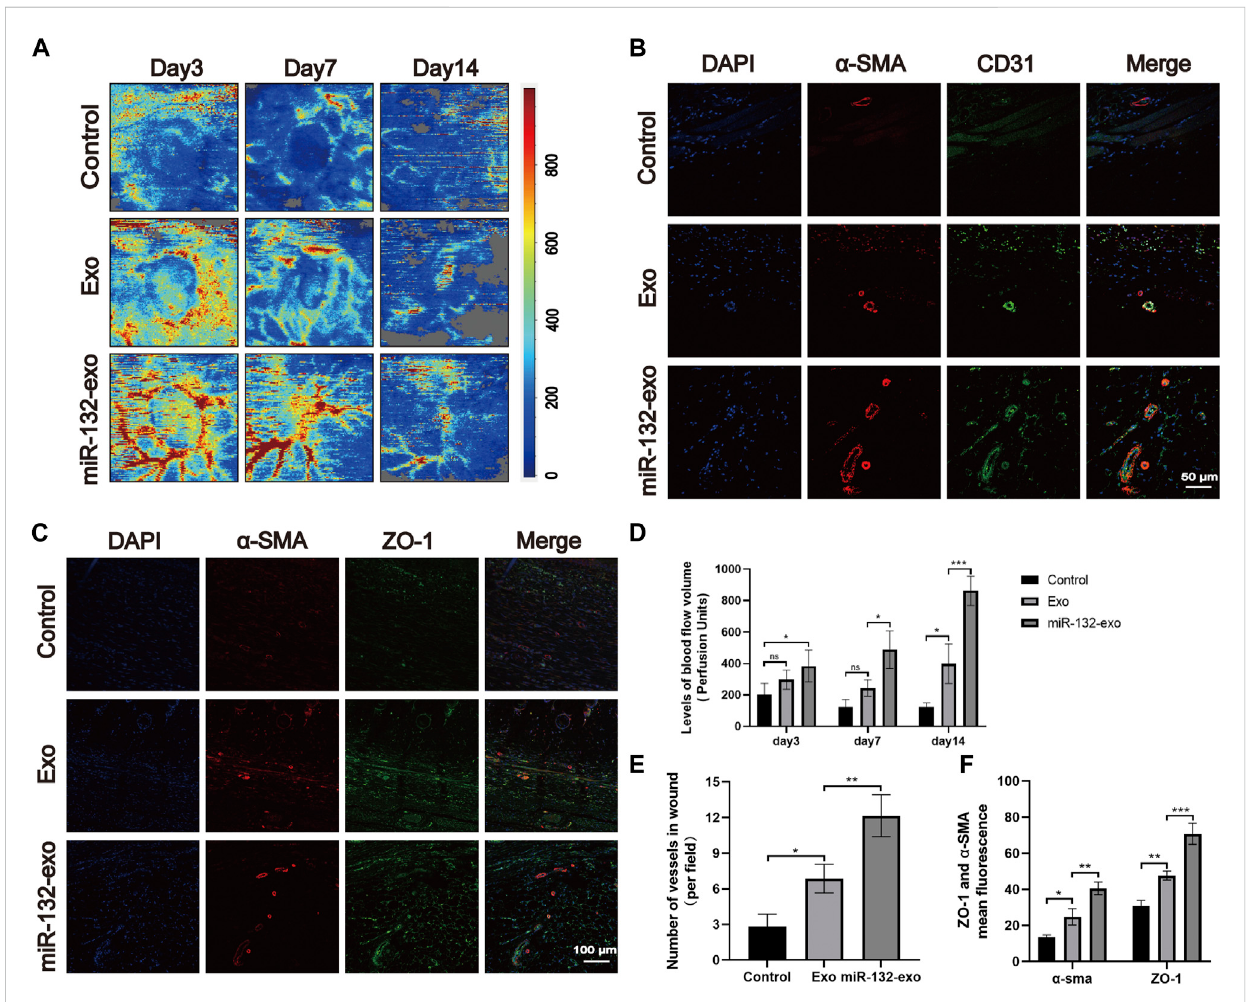
FIGURE 9 The miR-132-exo promoted angiogenesis and vascular network formation in diabetic wounds. (A) Representative laser Doppler images on postsurgery day3,7,and14; (B) Representativeco-stainingimagesof α -SMAandCD31 positivemicrovesselsineachgrouponday14,scale bar=50 μ m; (C) Representative immuno fl uorescence staining images of ZO-1 (red) and α -SMA (green) co-staining in each group on day 14, scale bar = 100 μ m; (D) Quantitative data of signal intensity of blood fl ow in diabetic wounds in each group; (E) Quanti fi cation of newly formed vessels per fi eld corresponding to co-staining of α -SMA and CD31; (F) Quanti fi cation of mean fl uorescence intensity per fi eld corresponding to co-staining of ZO-1 and α -SMA. * p < 0.05, ** p < 0.01, *** p < 0.001, data are presented as the mean ± SD, n =